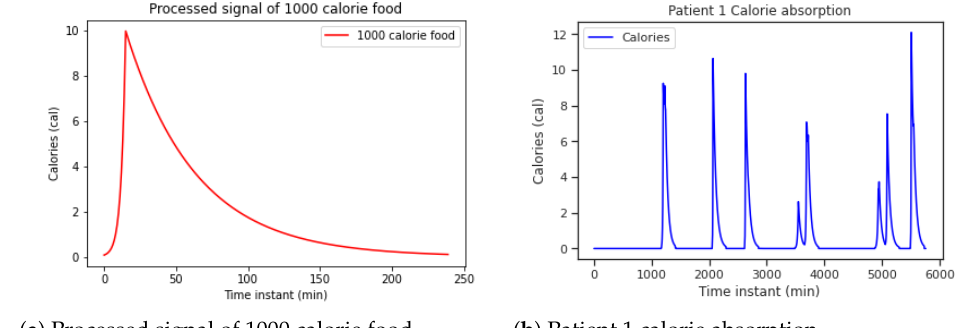
Figure 7. Patient 1 food data pre-processing.